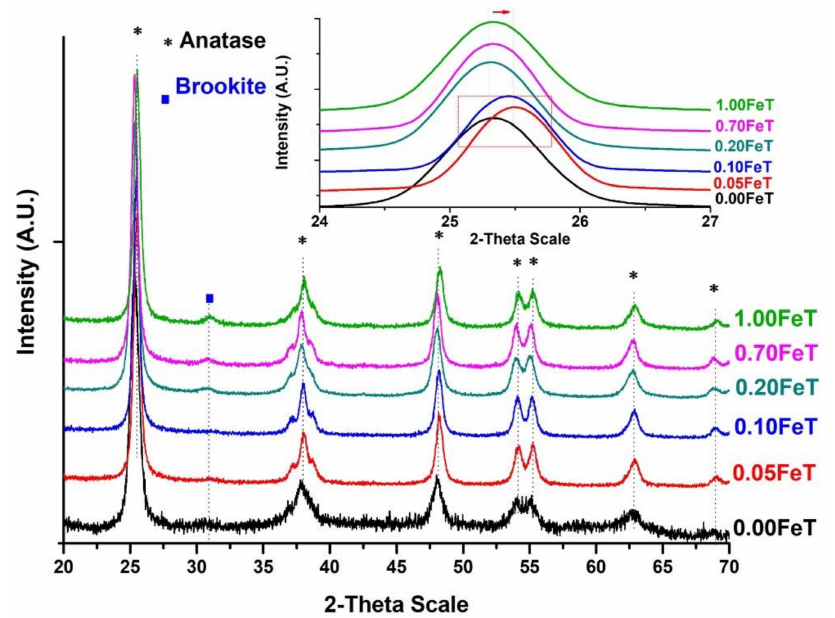
Figure 2. X-rays di ff ractograms of the doped and undoped TiO 2